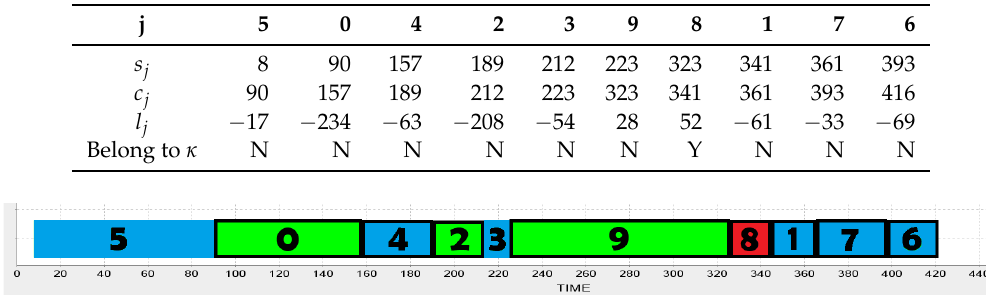
Figure 2. Graphics of the complementary schedule σ 9 .